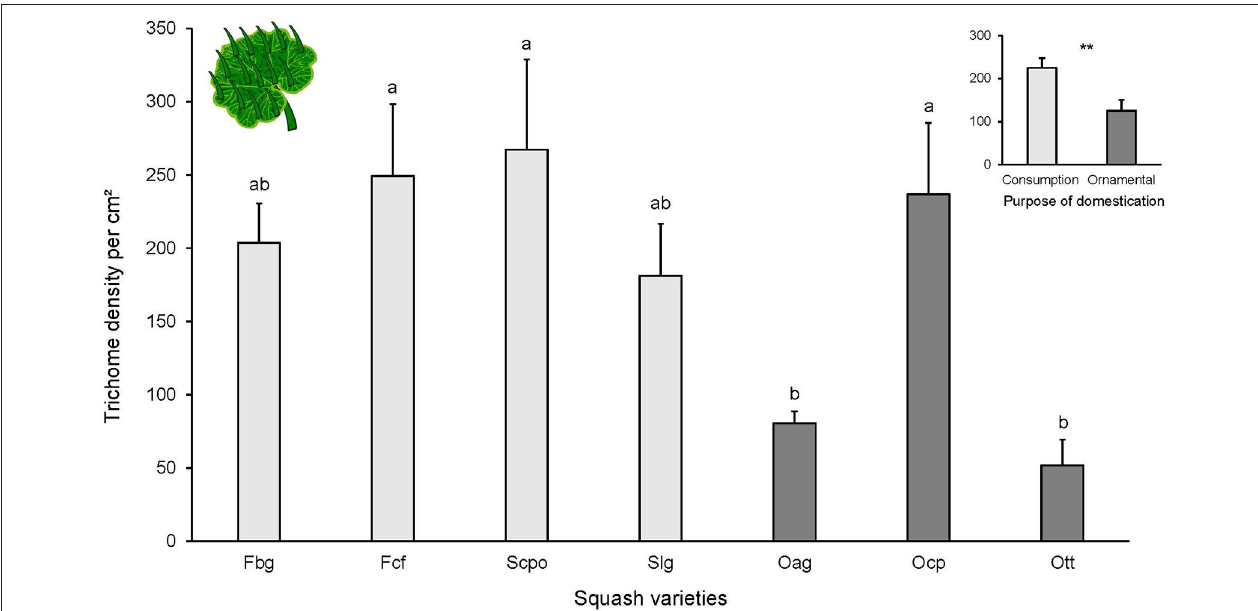
FIGURE 2 | Number of trichomes per cm ² on adaxial side of the leaves from different squash varieties ( n = 7). Bars represent means ( ± SE). Light-colored bars are varieties domesticated for consumption and dark-colored bars are varieties domesticated for an ornamental purpose. P -values are given for treatment comparisons with log transformed data [linear model], followed by pairwise comparisons of Least Squares Means (LS means). Upper graph is number of trichomes per purpose of domestication (consumption or ornamental). P -values are given for treatment comparison with glmer model with varieties as random factor. ** P <